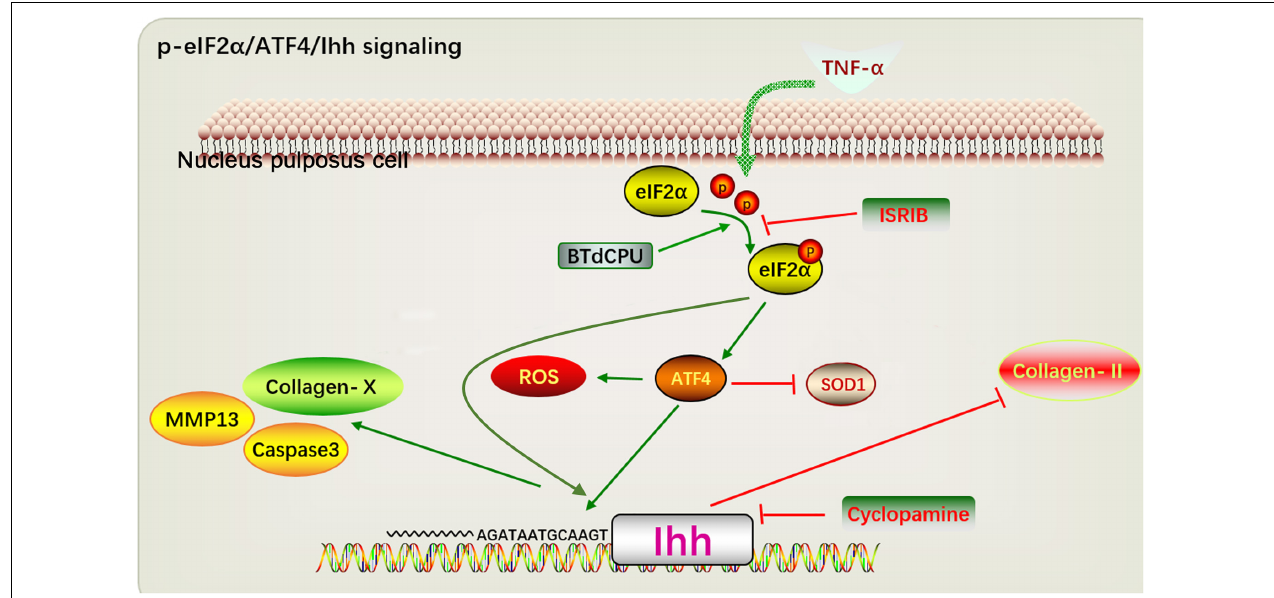
FIGURE 8 | A proposed model depicting the p-eIF2 α /ATF4/Ihh in regulating hypertrophy and apoptosis of NP cell. TNF- α and BTd promote the phosphorylation of eIF2 α and upregulate the ATF4 expression, continuously resulting in the Ihh activation. Suppression of eIF2 α phosphorylation by ISRIB decreases the ATF4 and Ihh levels and alleviates the hypertrophy and apoptosis of NP cell. Additionally, CPE treatment suppresses the hypertrophy and apoptosis of NP cell. Thus, disrupting the pathways ultimately protect against the development of IDD. p-eIF2 α , phosphorylated eukaryotic initiation factor-2 α ; ATF4, activating transcription factor 4; Ihh, Indian hedgehog; NP, nucleus pulposus; TNF, tumor necrosis factor; BTd, BTdCPU; eIF2 α , eukaryotic initiation factor-2 α ; CPE,